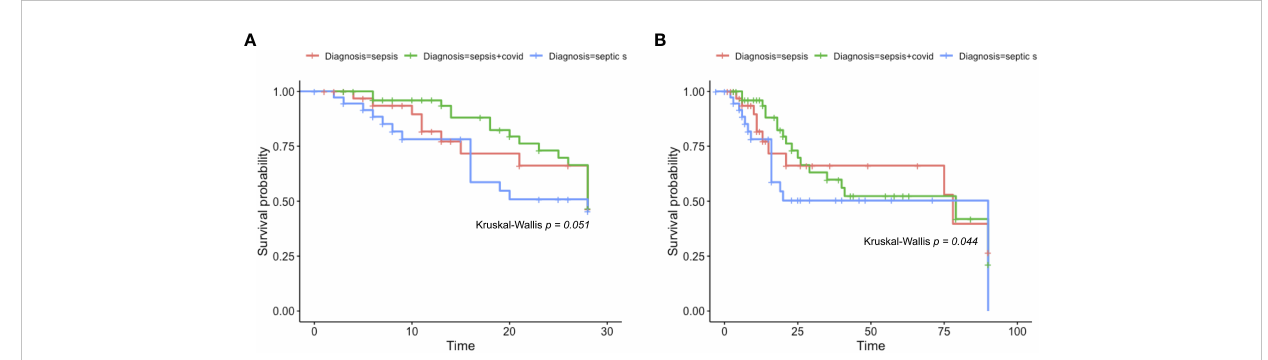
FIGURE 2 Kaplan-Meier survival rate. Kaplan-Meier survival probabilities were identi fi ed. In (A) , we show the Kaplan-Meier survival rate of sepsis, sepsis COVID, and septic shock patients after 28 days. Firstly, the data was identi fi ed as non-parametric (Shapiro-Wilk p = 1.377e-08) and the Kruskal-Wallis test was chosen to compare the averages ( p = 0.051). In (B) , we show the Kaplan-Meier curve for sepsis, sepsis COVID, and septic shock after 90 days, the data also follows a non-parametric distribution (Shapiro-Wilk = 6.036e-11) and the same Kruskal-Wallis test was employed to compare the averages ( p = 0.044).